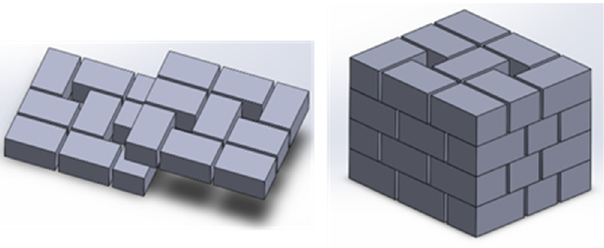
Figure 20. Staggered stacking.